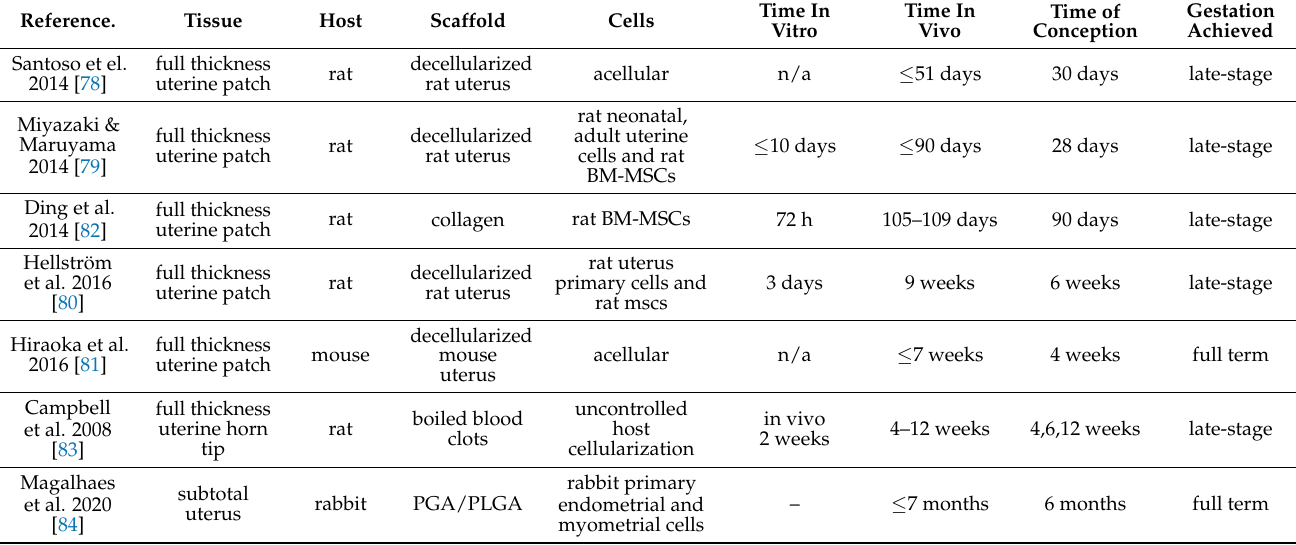
Table 2. Summary of tissue-engineering uterus models in